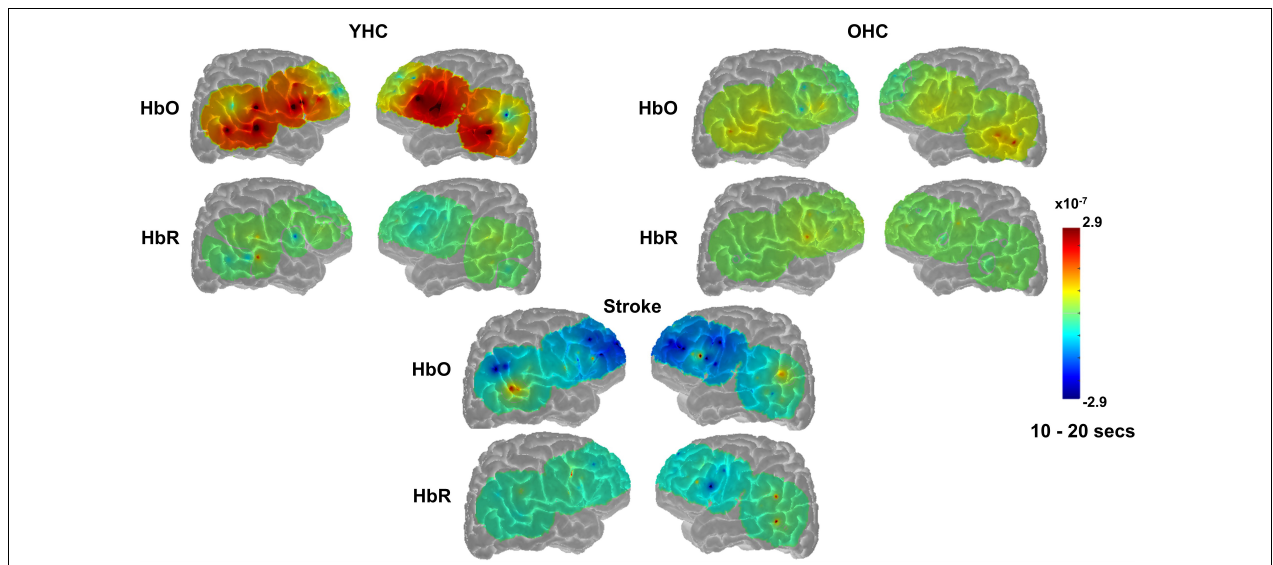
FIGURE 9 | Group mean HRF concentration overlays displaying the real minus scrambled picture contrast during picture naming. The color bar reflects the scale of the concentration change in µ M units. HbO, oxygenated hemoglobin concentration change; HbR, deoxygenated hemoglobin concentration change; YHC, younger healthy controls; OHC, older healthy controls.